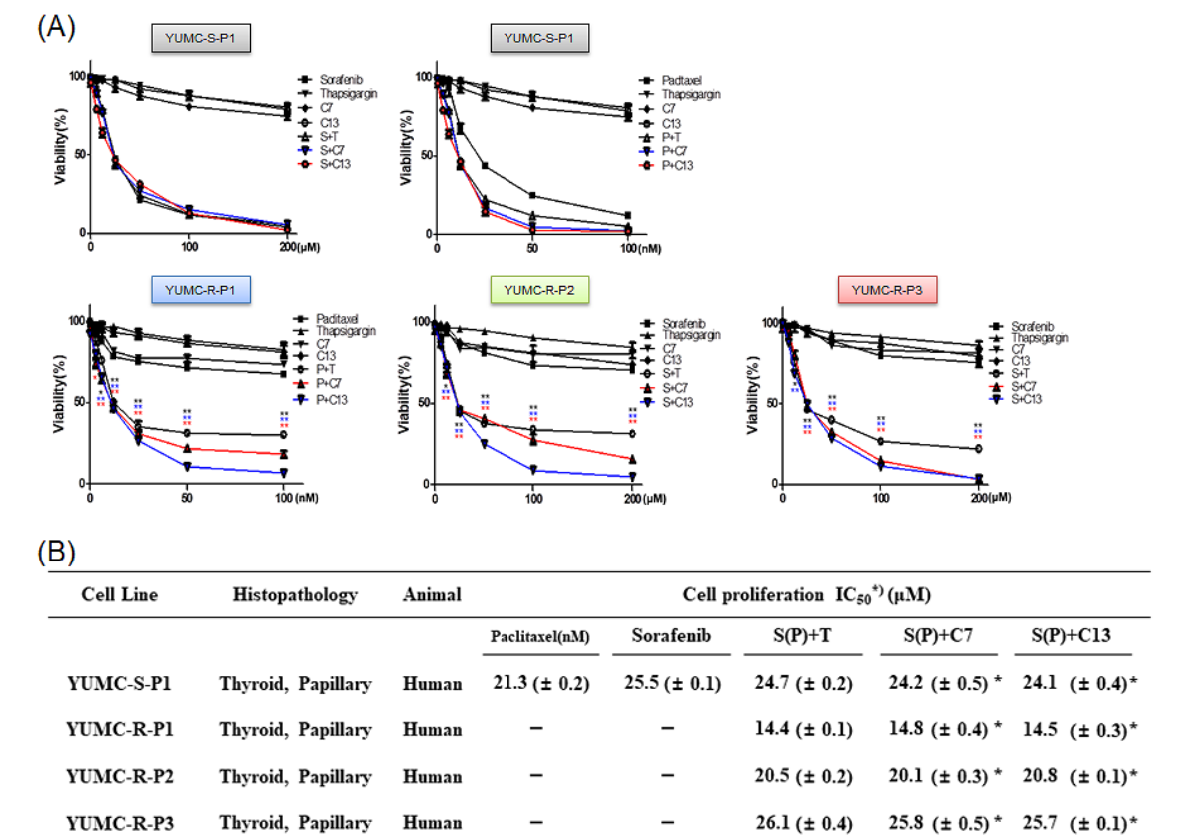
Figure 4. Anticancer efficacy of combination therapy using novel SERCA inhibitors (thapsigargin, positive control of SERCA inhibitor; candidate 7 and 13, novel SERCA inhibitors) and anticancer drugs (paclitxel or sorafenib). Comparative efficacy on antineoplastic-sensitive and paclitaxel- or sorafenib-resistant PTC cells. Cell viability of antineoplastic-sensitive ( A , YUMC-S-P1, top) and paclitaxel- or sorafenib-resistant ( A ). YUMC-R-P1, -R-P2, and -R-P3 (bottom) PTC cells after exposure to SERCA inhibitors and paclitaxel or sorafenib alone or in combination. Points represent the mean percentage of the values determined in the solvent-treated control. All experiments were performed in triplicate (minimum). Data represent mean ± standard deviation. * p < 0.05 and ** p < 0.01 versus control. *, ** paclitaxel or sorafenib + thapsigargin versus control, *, ** paclitaxel or sorafenib + candidate 7 versus control, *, ** paclitaxel or sorafenib + candidate 13 versus control. ( B ). IC 50 values of the combination of SERCA inhibitors with paclitaxel or sorafenib in antineoplastic-sensitive and paclitaxel- or sorafenib-resistant PTC cells. Each data point corresponds to the mean of three separate MTT assays, carried out in triplicate. SEM, standard error of the mean; MTT, 3-(4,5-dimethylthiazol-2-yl)-2,5-diphenyltetrazolium bromide; IC 50 , half-maximal inhibitory concentration. The asterisk indicates lowest half-maximal inhibitory concentration.